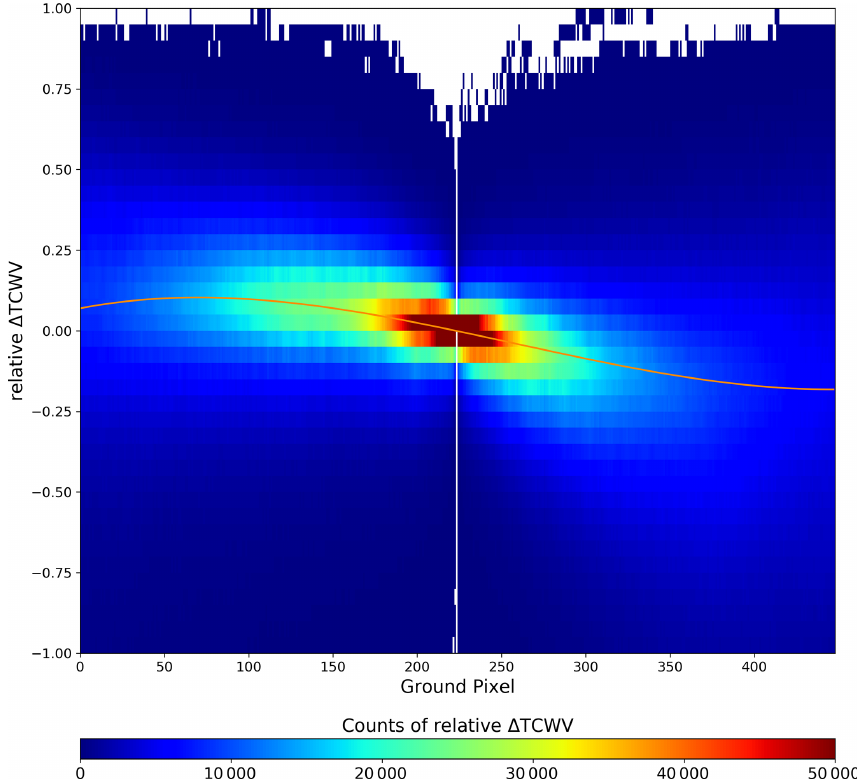
Figure 4. The number of measurements, i.e. counts of the relative difference between the albedo and cloud-corrected S5P TCWV to the nadir value for every ground pixel for February 2020. The orange line is a third-degree fitted polynomial.